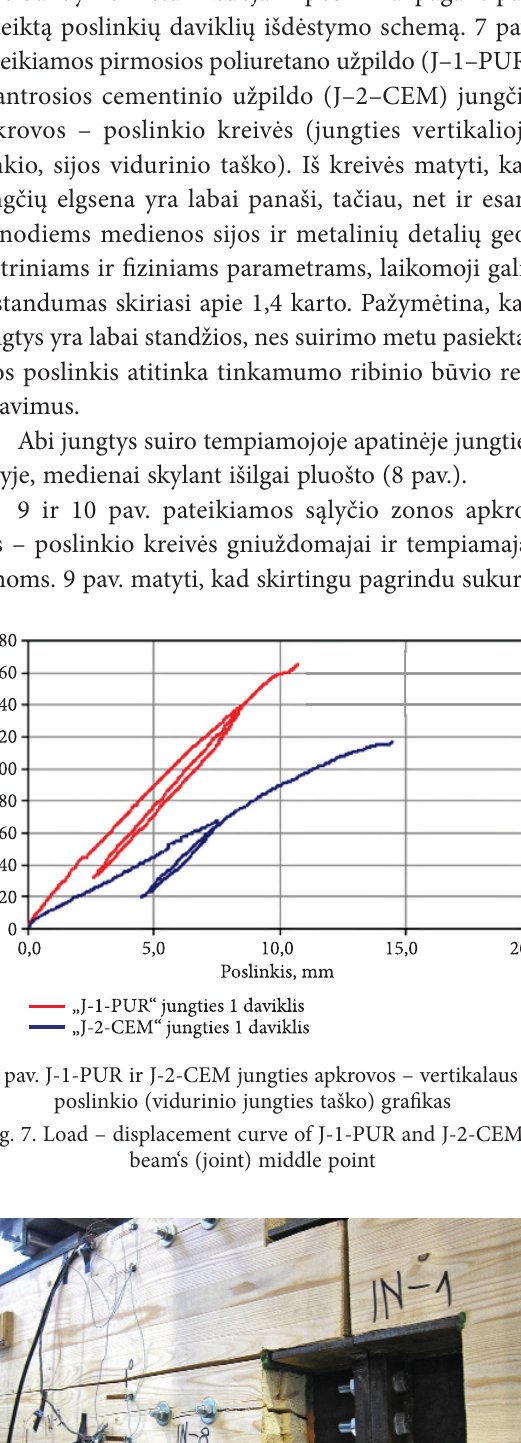
Table 1. Manufacturers‘ declared mechanical